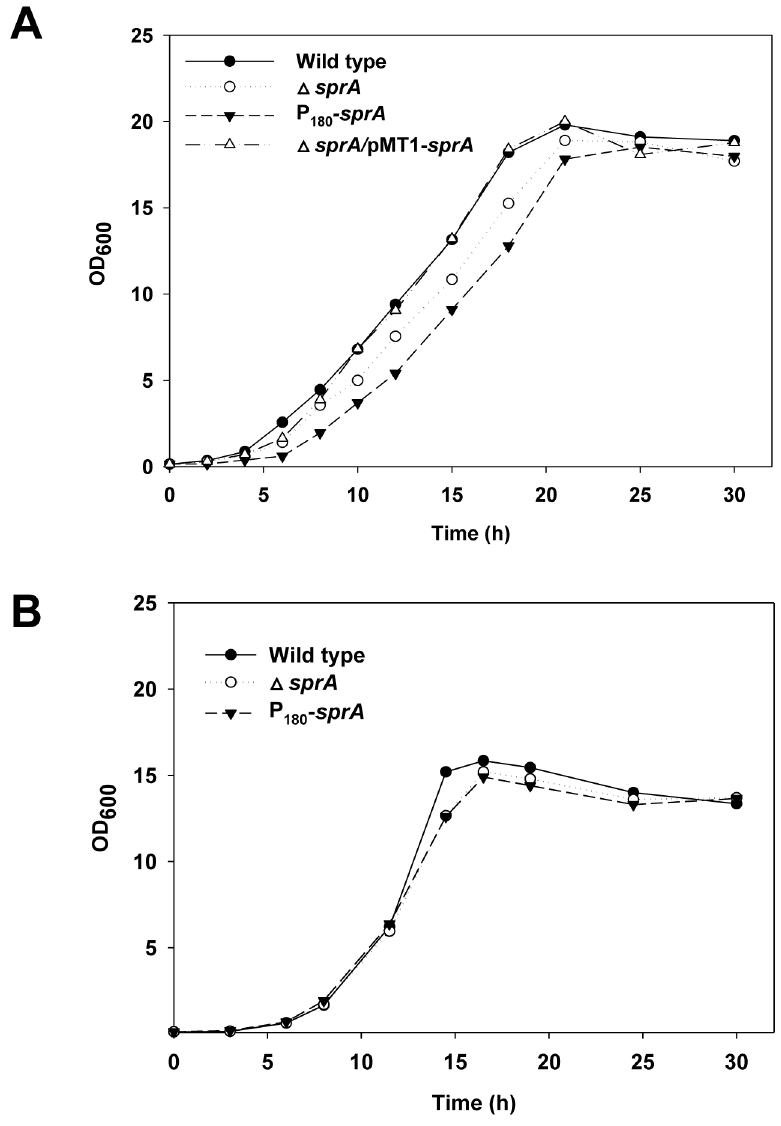
N , wild-type C. glutamicum ; # , C. glutamicum D sprA ; . , C. glutamicum